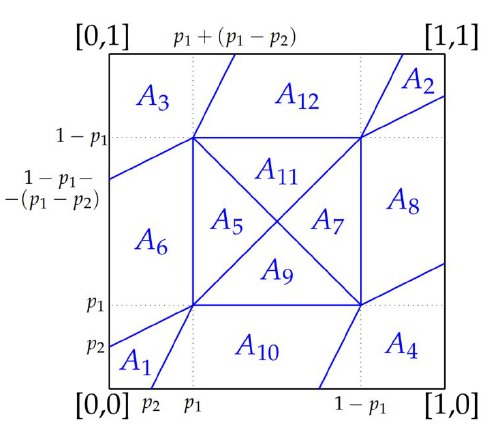
Figure 3. The 12 areas of the unique square corresponding to Equation